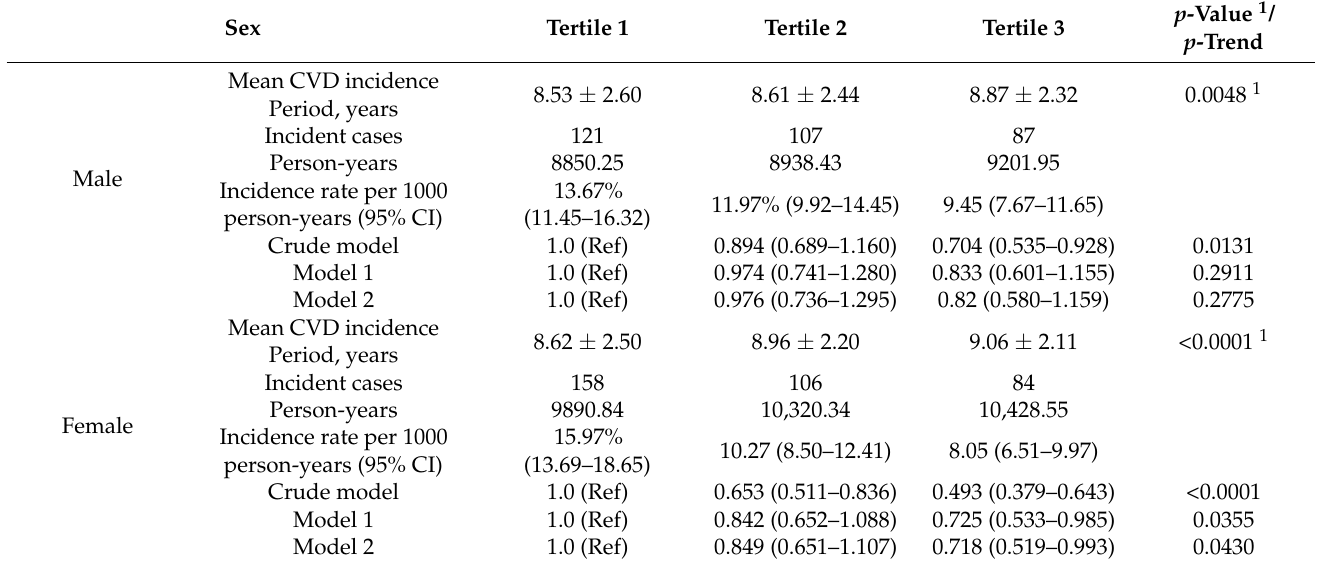
Table 4. Hazard ratios (95% confidence intervals) of CVD incidence according to seafood-intake